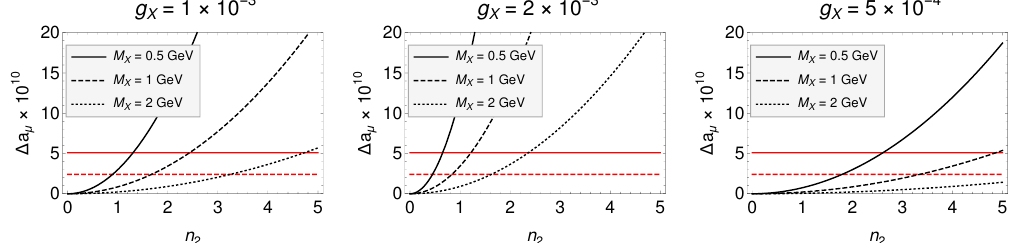
M X = 0.5GeV M X = 1GeV